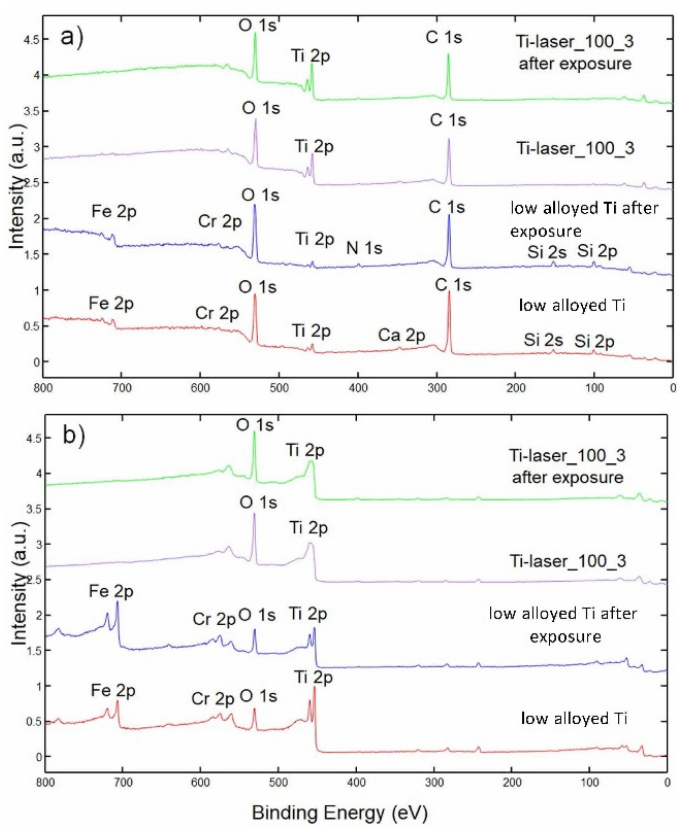
Figure 6. XPS survey spectra of low alloyed Ti before and after exposure to 0.1 M NaCl solution and laser marked Ti surface Ti-100-3 before and after exposure to 0.1 M NaCl solution; ( a ) at the surface and ( b ) at a depth of 25 nm.